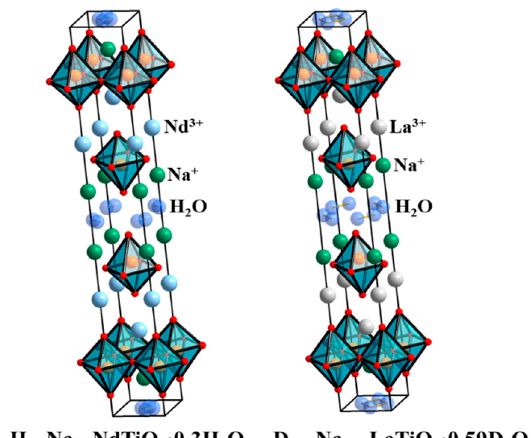
Figure 6. Comparison of the H 0.7 Na 0.3 NdTiO 4 · 0.3H 2 O (this work) and D 0.34 Na 0.66 LaTiO 4 · 0.59D 2 O (data from [63]) structures. Equivalent positions of water are connected by lines.